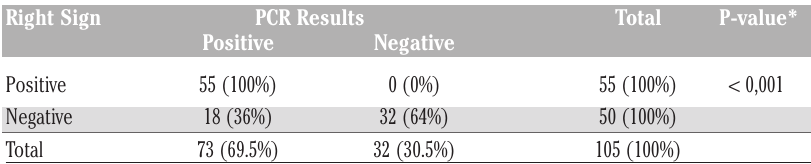
Table 4. Comparison of RightSign vs. PCR